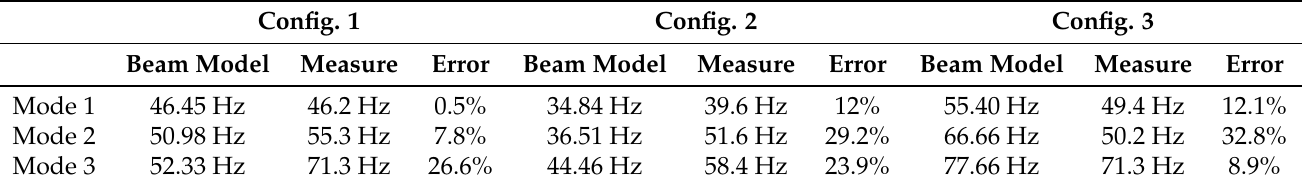
Table 1. Comparison of measured natural frequencies and calculated ones with the proposed method. Config.